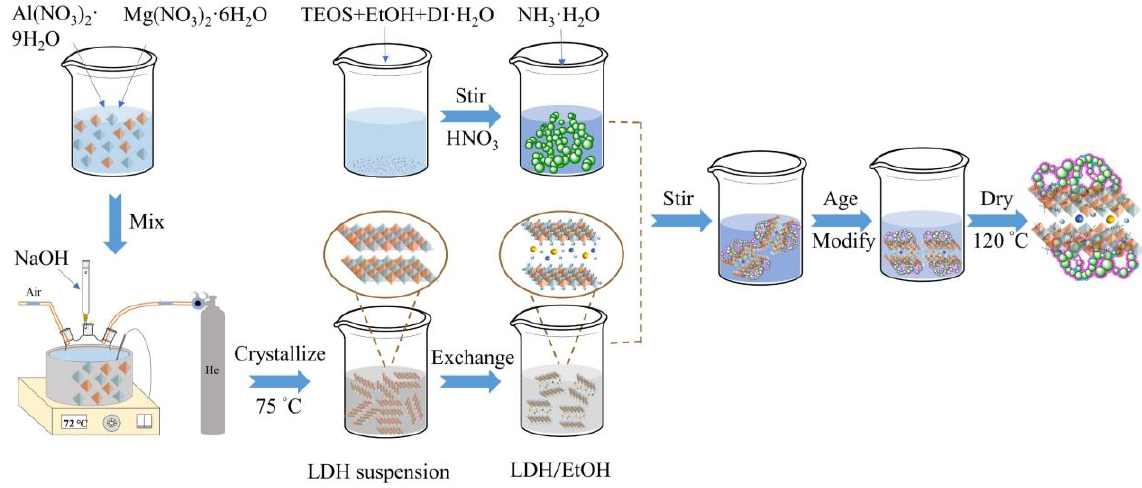
Figure 13. Flow chart of the process for synthesizing LDH/SA composites. Figure 14. Flow chart of the process for synthesizing LDH/SA